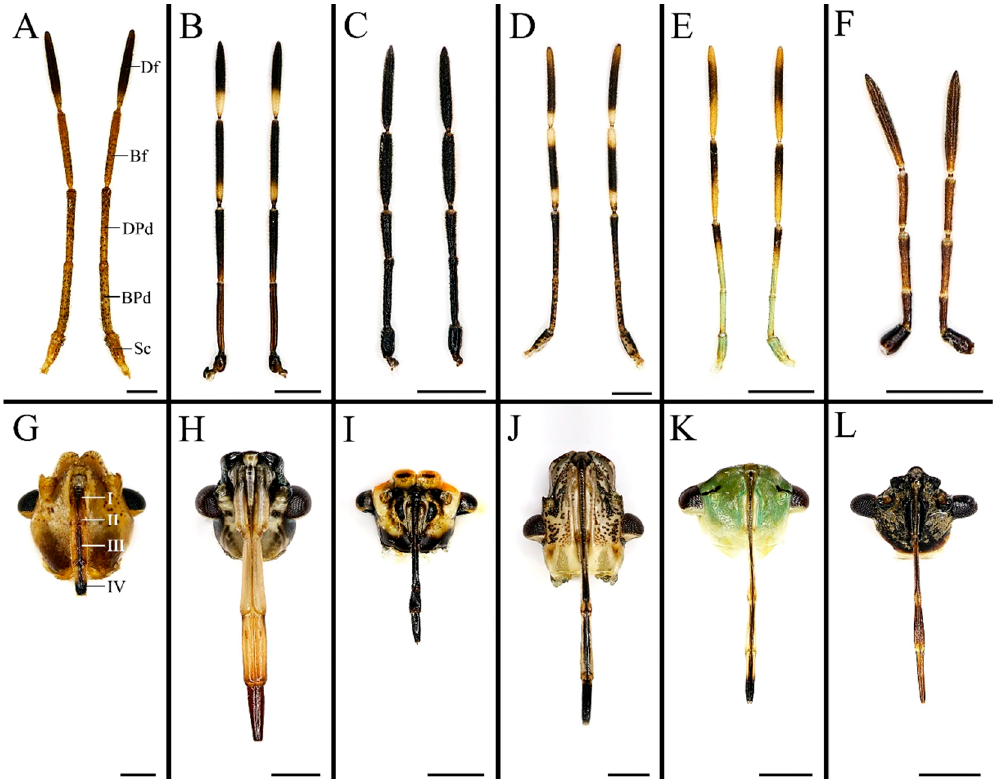
Figure 1. Antennae and labia of six pentatomid species examined in present study. ( A , G ) Cressona divaricata , ( B , H ) Eocanthecona furcellata , ( C , I ) Eurydema dominulus , ( D , J ) Halyomorpha halys , ( E , K ) Plautia crossota , and ( F , L ) Scotinophara lurida . Scale bars: ( A – L ) 1 mm. Abbreviations: Bf, basiflagellomere; BPd, basal pedicel; Df, distiflagellomere; DPd, distal pedicel; and Sc, scape.